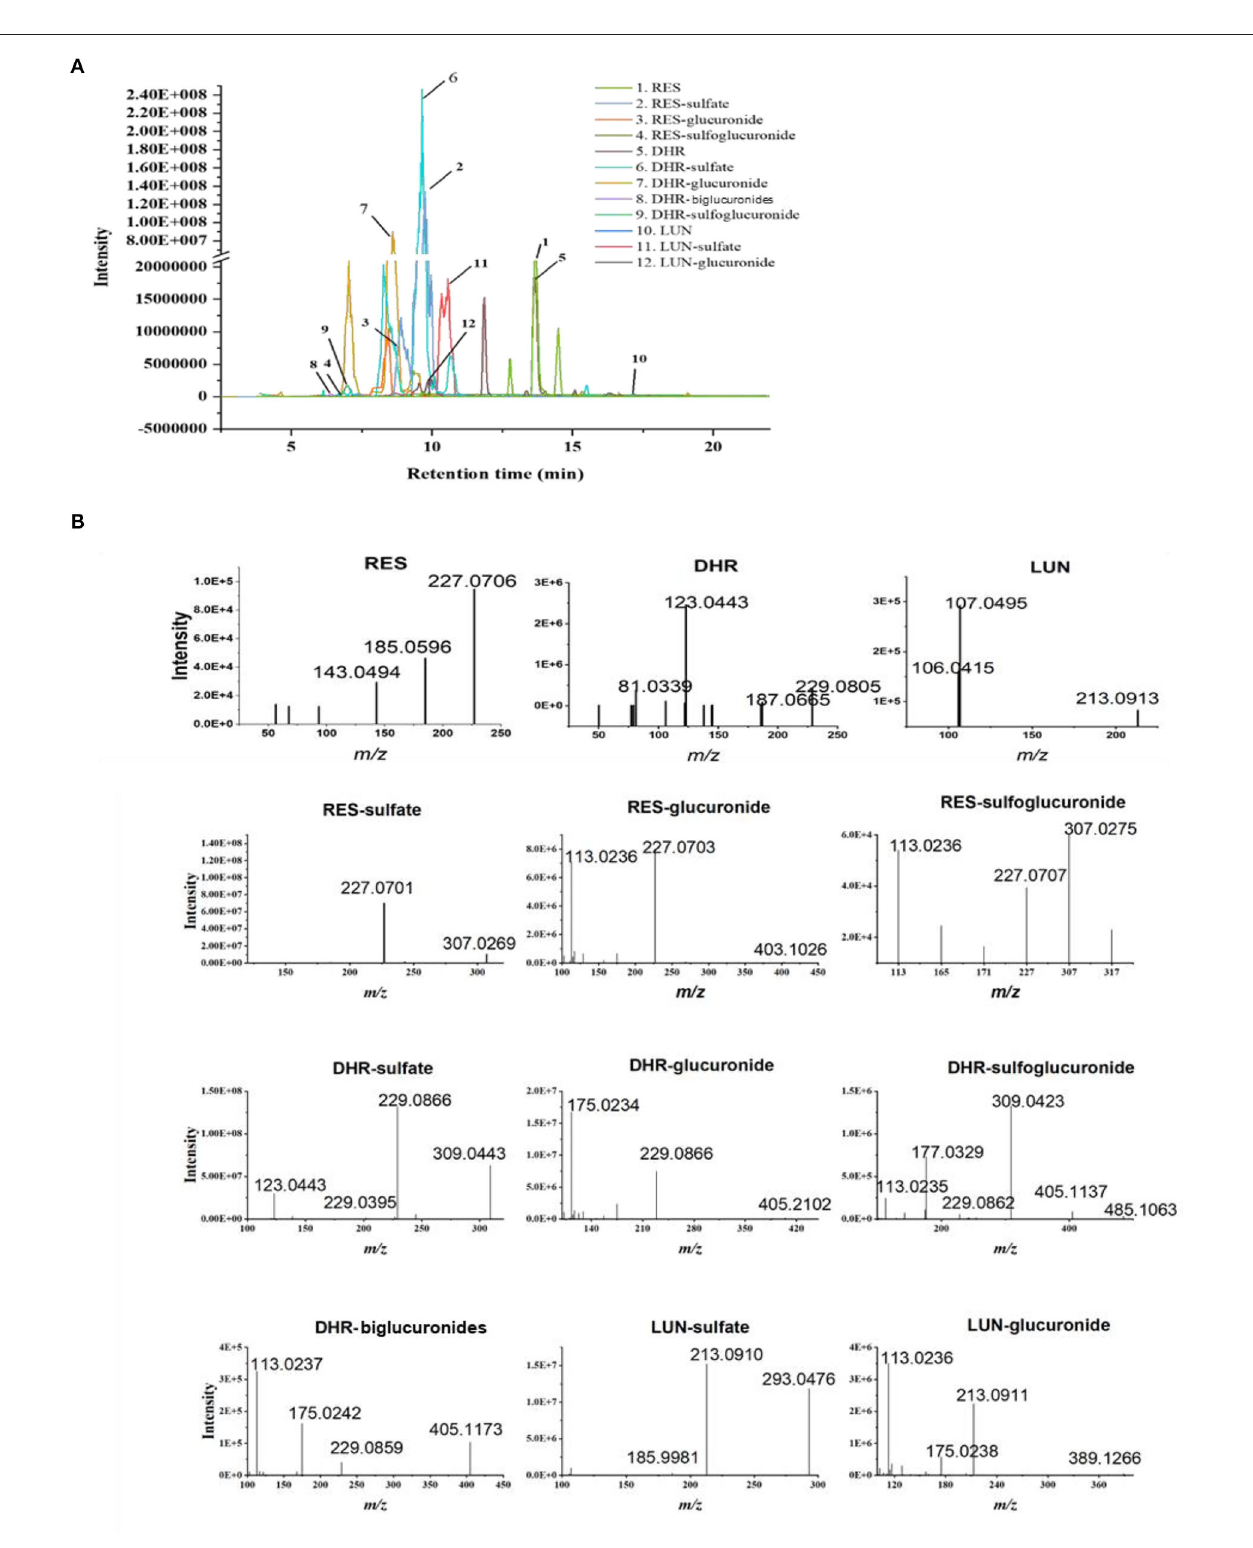
FIGURE 1 | Identification of RES metabolites with HPLC-MS/MS. Chromatograms of 11 RES metabolites identified in the urine and feces after sustained oral consumption of RES with HPLC-MS/MS (A) . The MS/MS spectra of RES, DHR, LUN, RES-sulfate, RES-glucuronide, RES-sulfoglucuronide, DHR-sulfate, DHR-glucuronide, DHR-biglucuronides, DHR-sulfoglucuronide, LUN-sulfate and LUN-glucuronide (B) .